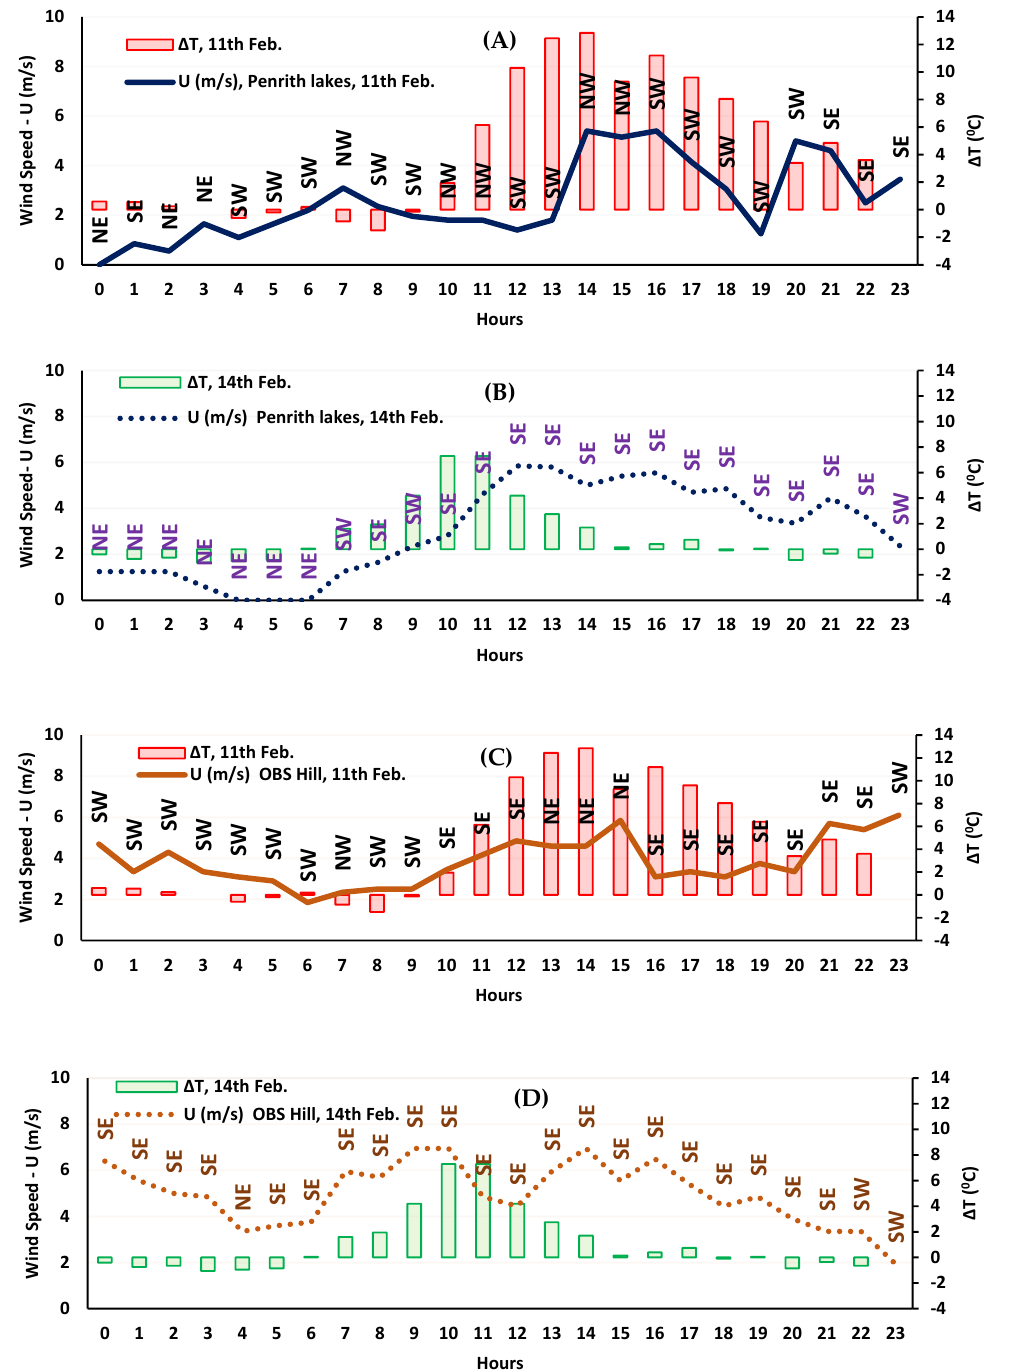
Figure 4. Wind speed-U (m / s) and direction comparison with urban overheating ( ∆ T) at Penrith Lakes and OBS Hill during selected HW (11 February 2017) and NHW (14 February 2017) days. ( A ): Penrith Lakes during HW day, ( B ) Penrith Lakes during NHW day, ( C ) OBS Hill during HW day, ( D ) OBS Hill during NHW day.